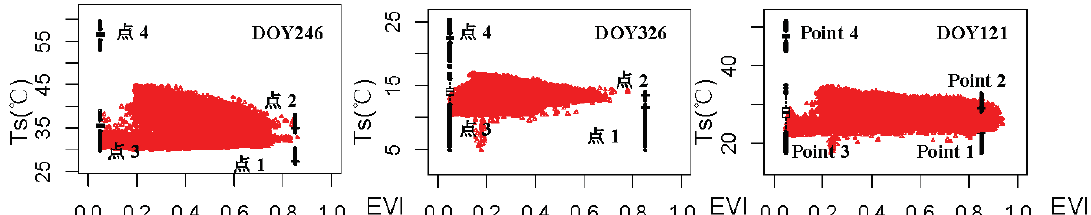
Fig. 3 Box-and-whisker plots of calculated T s at four vertices of T s -EVI trapezoids of three dates: (a) DOY246 in 2013; (b) DOY326 in 2013; (c) DOY121 in 2014. (For each boxplot, the bottom and top of the box are the first and third quartiles, the band inside the box is the median, the lower whisker is the lowest datum still within 1.5 IQR (interquartile range) of the lower quartile, and the upper whisker is the highest datum still within 1.5 IQR of the upper